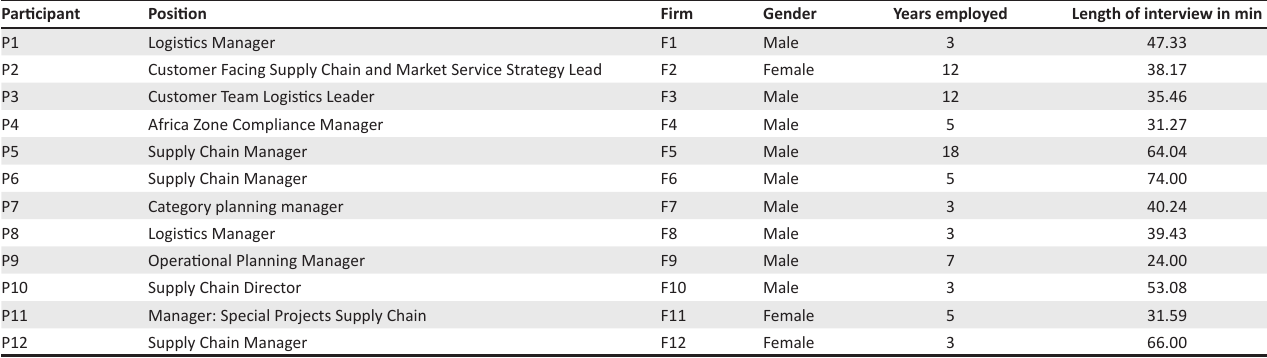
TABLE 1: A profile of the study participants. Participant Position Customer Facing Supply Chain and Market Service Strategy Lead Customer Team Logistics